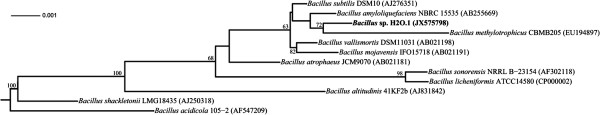
16S rRNA gene based phylogenetic tree showing affiliation of the Bacillus
sp.H2O-1 strain with related species of the genus Bacillus. The phylogenetic tree was constructed with Bacillus acidicola as the outgroup using the Tree Builder algorithm of the Ribosomal Data Base Project (http://rdp.cme.msu.edu/index.jsp). Numbers at the internal nodes represent bootstrap values (> 50%). Bar = 0.001% substitutions per site.